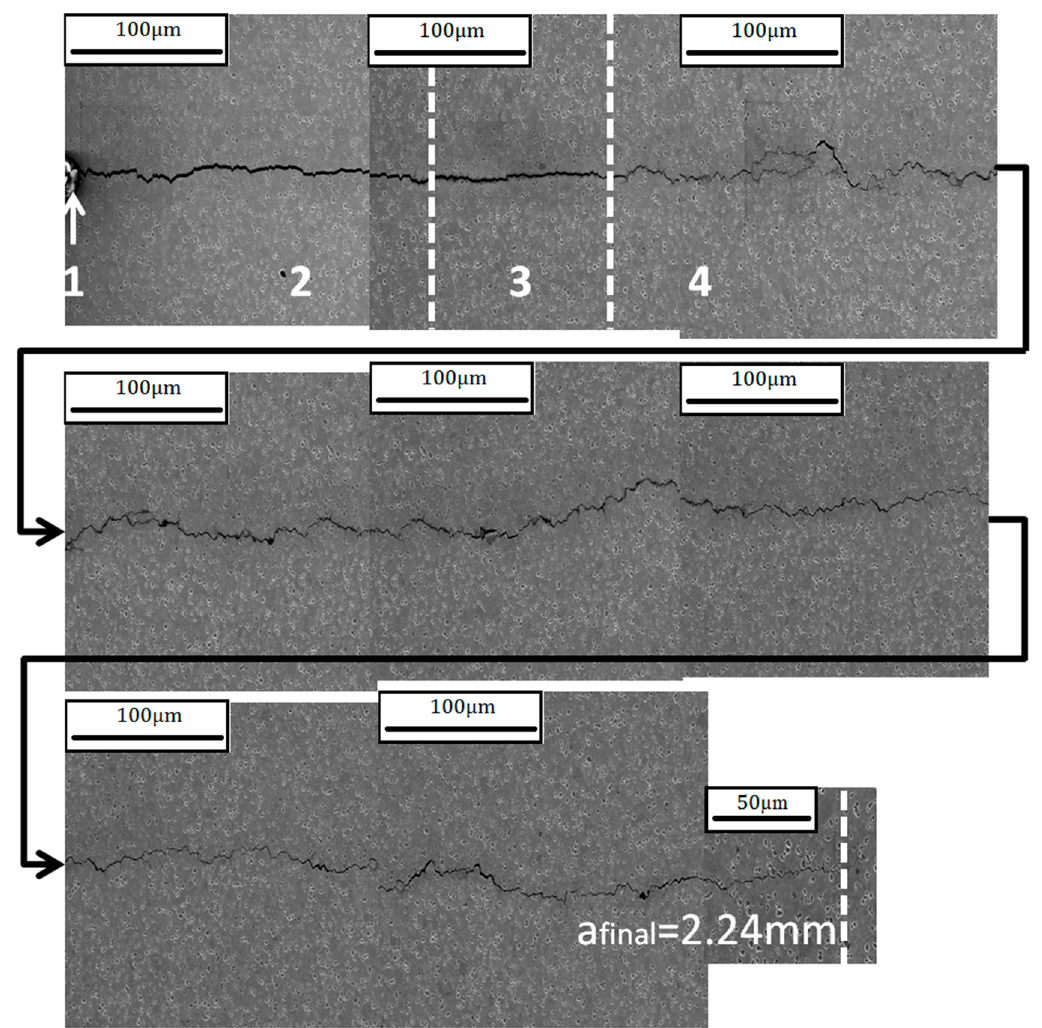
Figure 18. Crack progression of the 500 s 90° OOP ACW test.